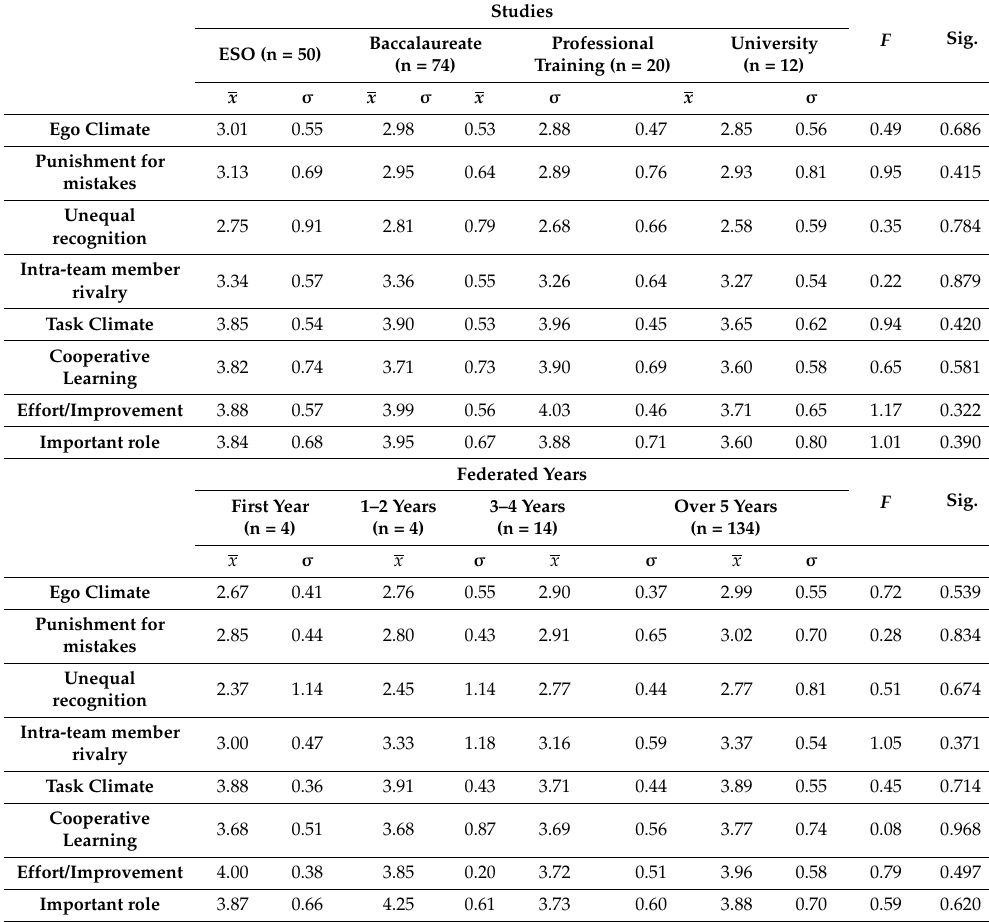
Table 3. Motivational Climate, studies, Federated years and